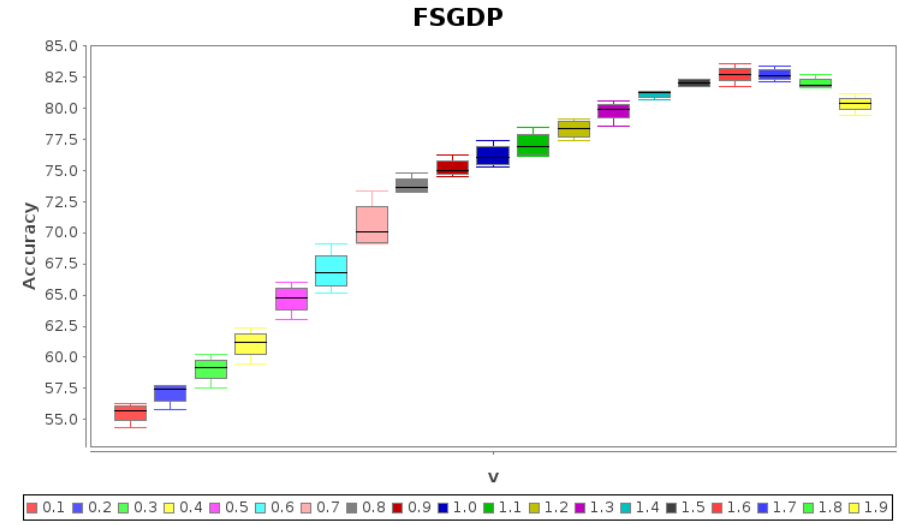
Figure 5. Experiment 2.1: FSGDP cross-folding accuracies, K = 4 folds, ν ∈ [ 0.1,1.9 ] .